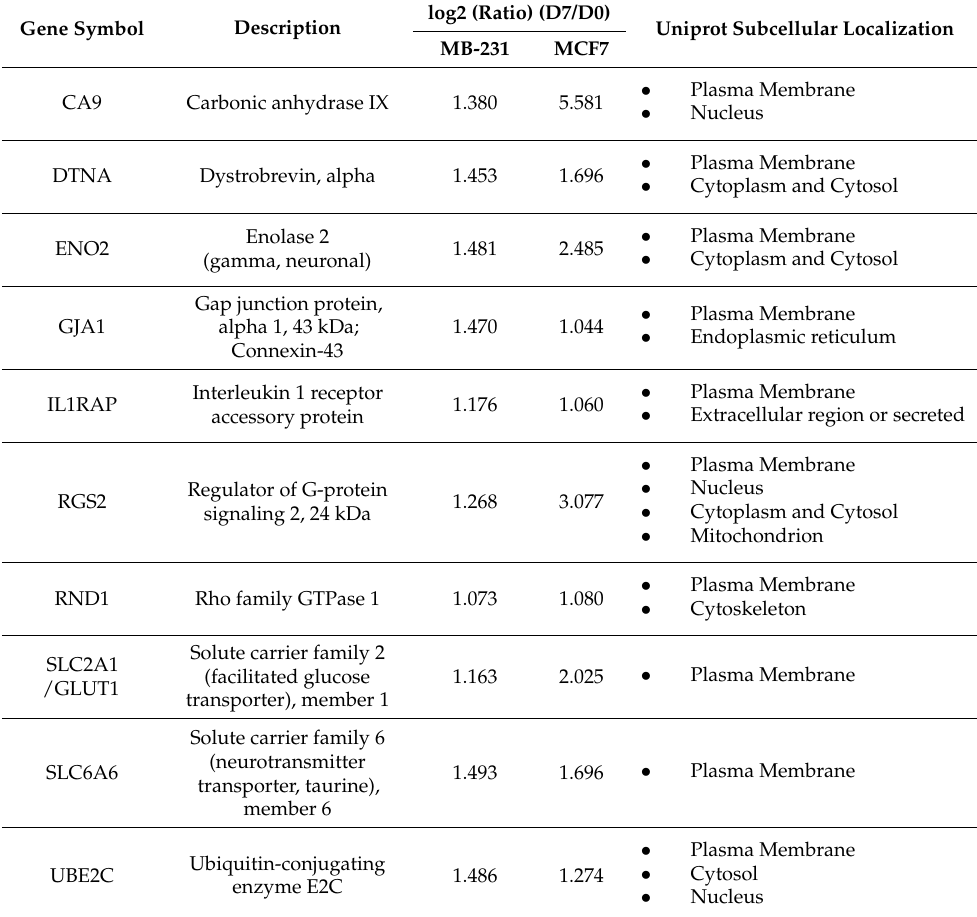
Table 1. Predicted protein localization of the top 10 genes of the 55 upregulated common genes, using Uniprot to identify plasma membrane-localized